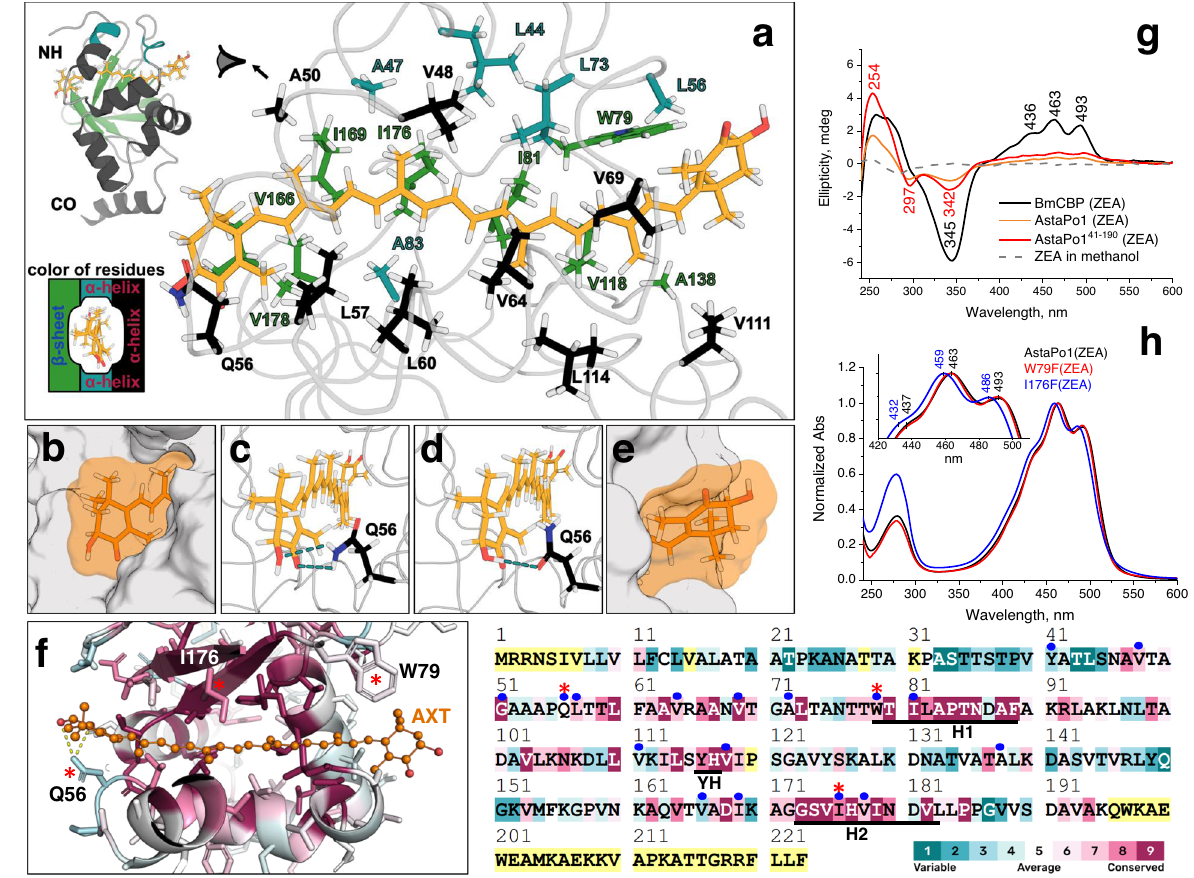
Fig. 3 AXT binding mode and AstaPo1 – pigment interactions. a – e Different views of the carotenoid binding tunnel of AstaPo1. The coloring scheme in panel a is indicated. b , e Polar headgroups of AXT exiting the protein molecule from both sides of the carotenoid-binding tunnel. The Connolly surface with solvent radius 1.4 Å of AstaPo1 and the carotenoid is shown in gray and orange, respectively. c , d Polar contacts formed between the AXT polar groups and the side chain of the non-conserved Q56 residue of AstaPo1. f Amino acid conservation mapped onto the tertiary (left) and primary structure of AstaPo1 (right), according to Consurf 69 analysis of 150 FAS1 domain-containing homologs using the scale shown in the bottom right corner (yellow color indicates positions with insuf fi cient data). The full AstaPo1 sequence is presented for the numbering consistency (residues 1 – 223). Red asterisks mark the peculiar positions discussed in the text. Blue circles highlight 17 residues whose solvent-accessible surface area changes by at least 10 Å 2 upon AXT binding. FAS1- speci fi c conserved motifs H1, H2, and YH are indicated by black bars. g Vis-UV CD spectra of AstaPo1(ZEA) and its truncated variant AstaPo1 41 – 190 (ZEA) as compared with the spectra of BmCBP(ZEA) and free ZEA in methanol. The main extrema are indicated in nm. h Absorbance spectra of AstaPo1, its W79F and I176F variants puri fi ed from E. coli cells synthesizing